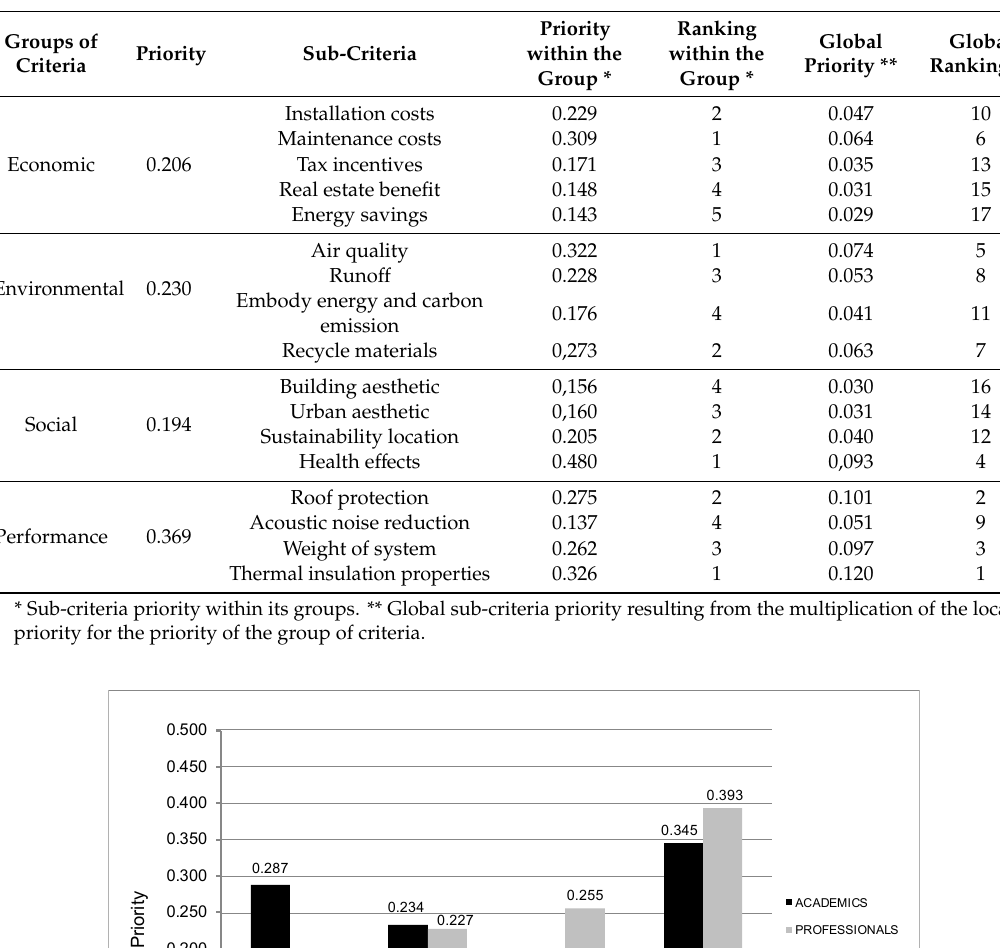
Table 4. Priorities of criteria and sub-criteria.